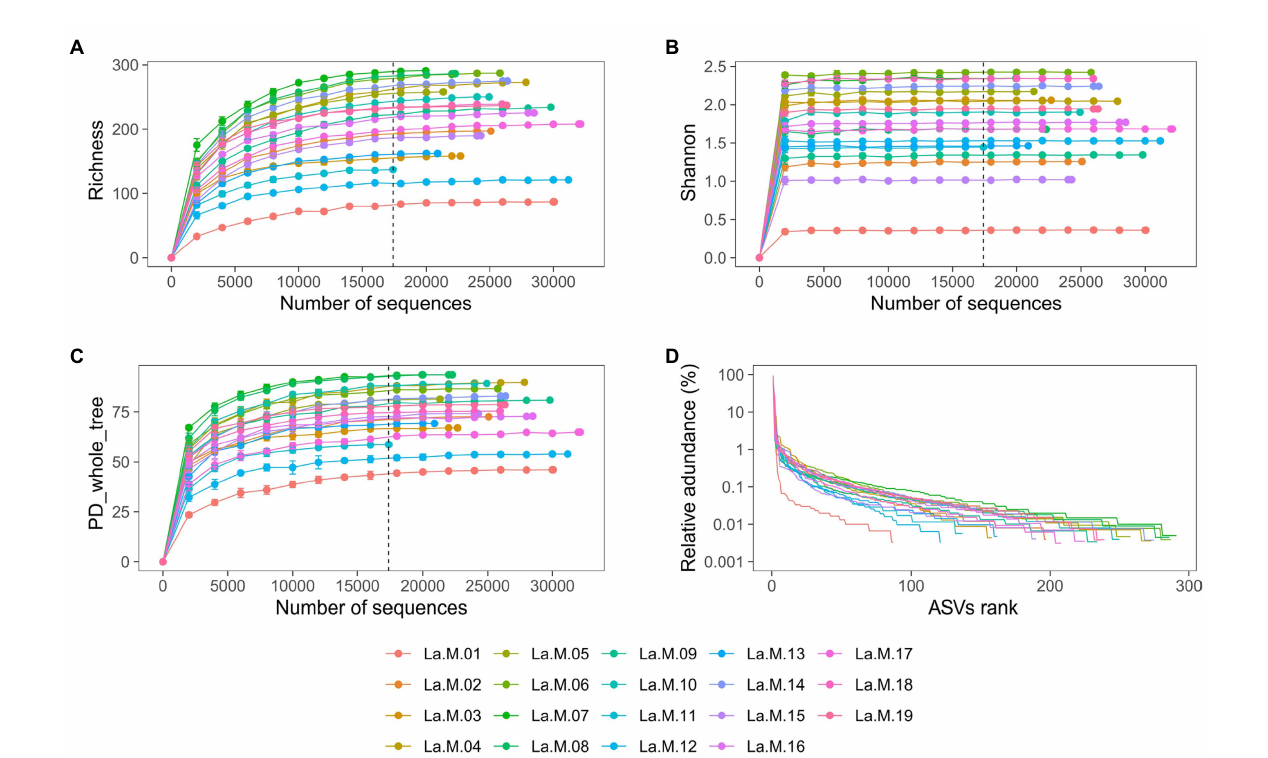
FIGURE 1 Sequencing depth analysis and ASVs distribution of gut microbiota in L. a. rubrogularis and L. a. vernayi . Rarefaction curves of gut microbiota of all samples based on Illumina MiSeq sequencing. Horizontal axis: the amount of effective sequencing data; vertical axis: (A) the observed number of operational taxonomic units (richness index); (B) Shannon index; (C) and PD_whole_tree. (D) Rank abundance curve of gut microbiota of Leiothrix argentauris . Horizontal axis: the number of ASVs according to the abundance, from high to low. Vertical axis: the abundance of ASVs. The larger the span curve on the horizontal axis, the higher the species richness. The smoother the curve on the vertical axis, the more even the species